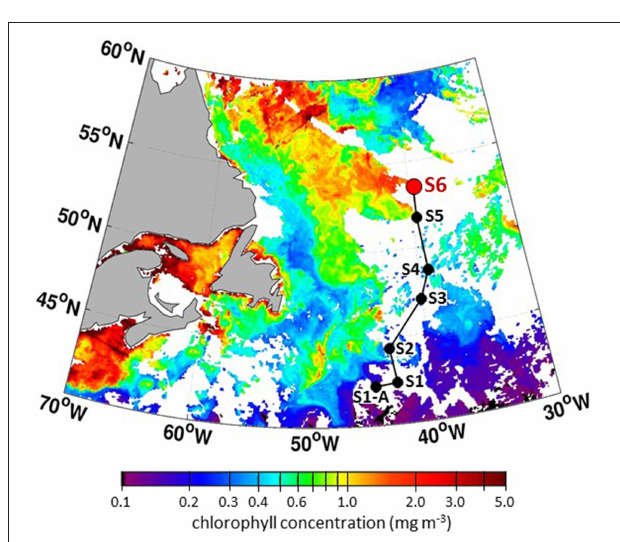
FIGURE 13 | Composite MODIS chlorophyll concentrations for September 2–4, 2017 (dates with the best satellite coverage during NAAMES 3) showing stations along “science intensive” transit and massive feature extending from Station S6 (NAAMES 3) into the Labrador